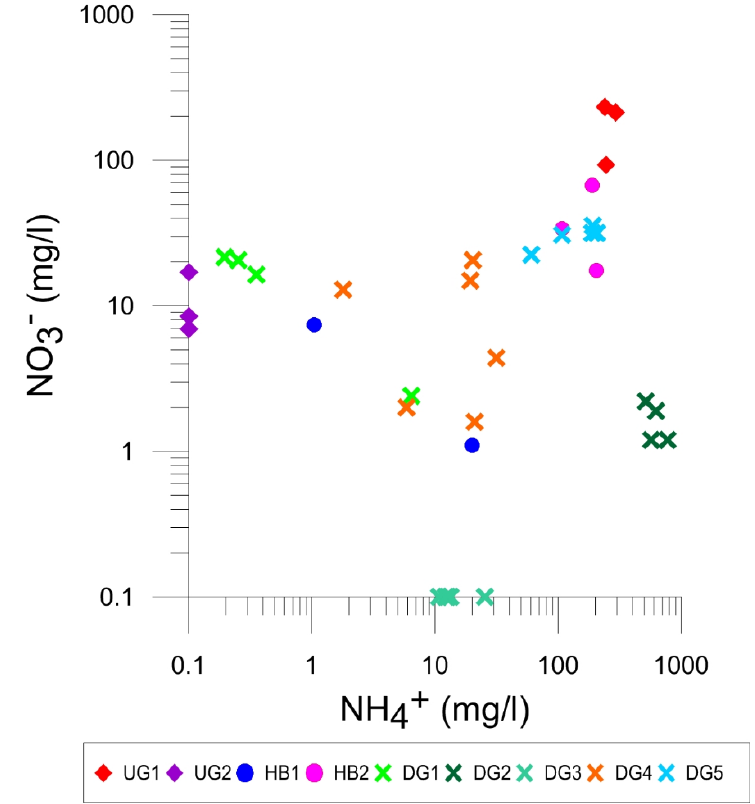
Figure 4. Plot of NH 4+ versus NO 3 − in samples analysed from MLS located upgradient (UG1, UG2), near the hydraulic barrier (HB1, HB2) and downgradient (DG1 ÷ DG5) with respect to the hydraulic barrier (see Figure 1 for sampling site location).